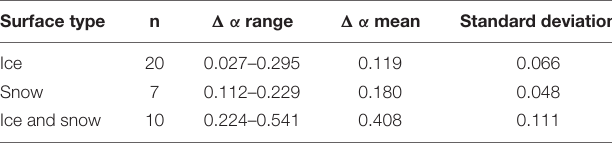
TABLE 2 | Characteristics of variation in diurnal albedo records ( (cid:49) α ) in AWS between 26 June and 2 August